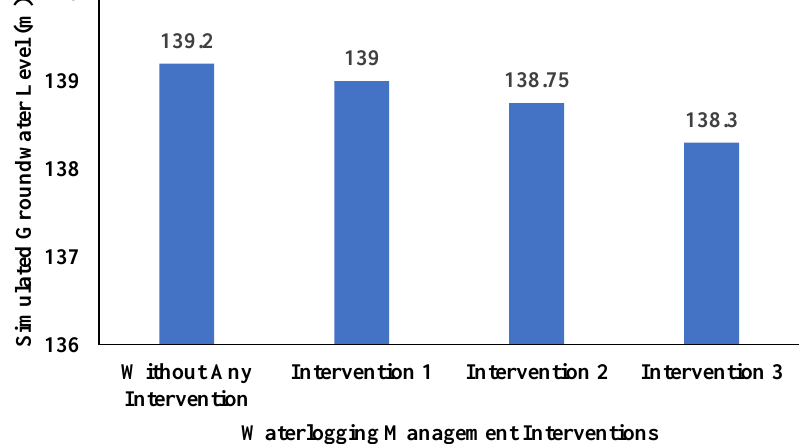
Figure 12. Simulated Groundwater Levels with and without Waterlogging Management Interven- tions.